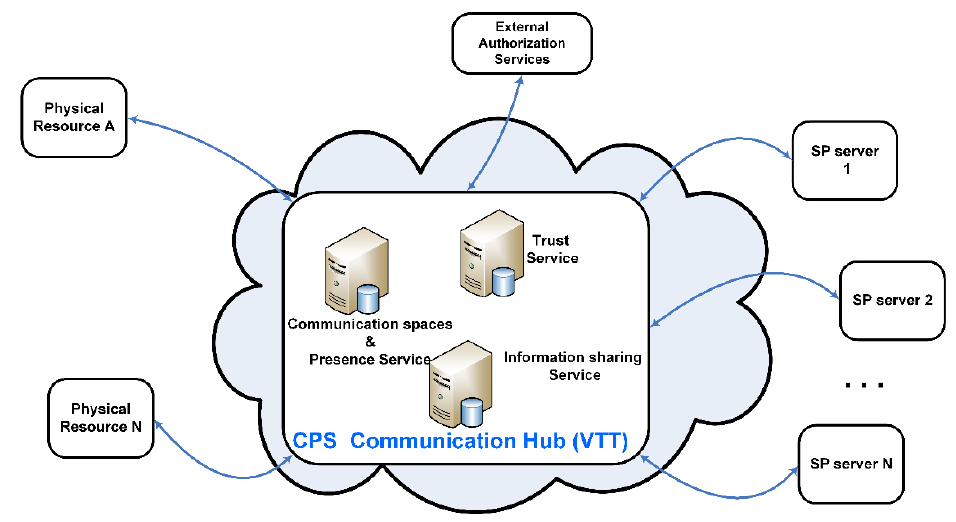
12. Services of the CPS hub. Figure